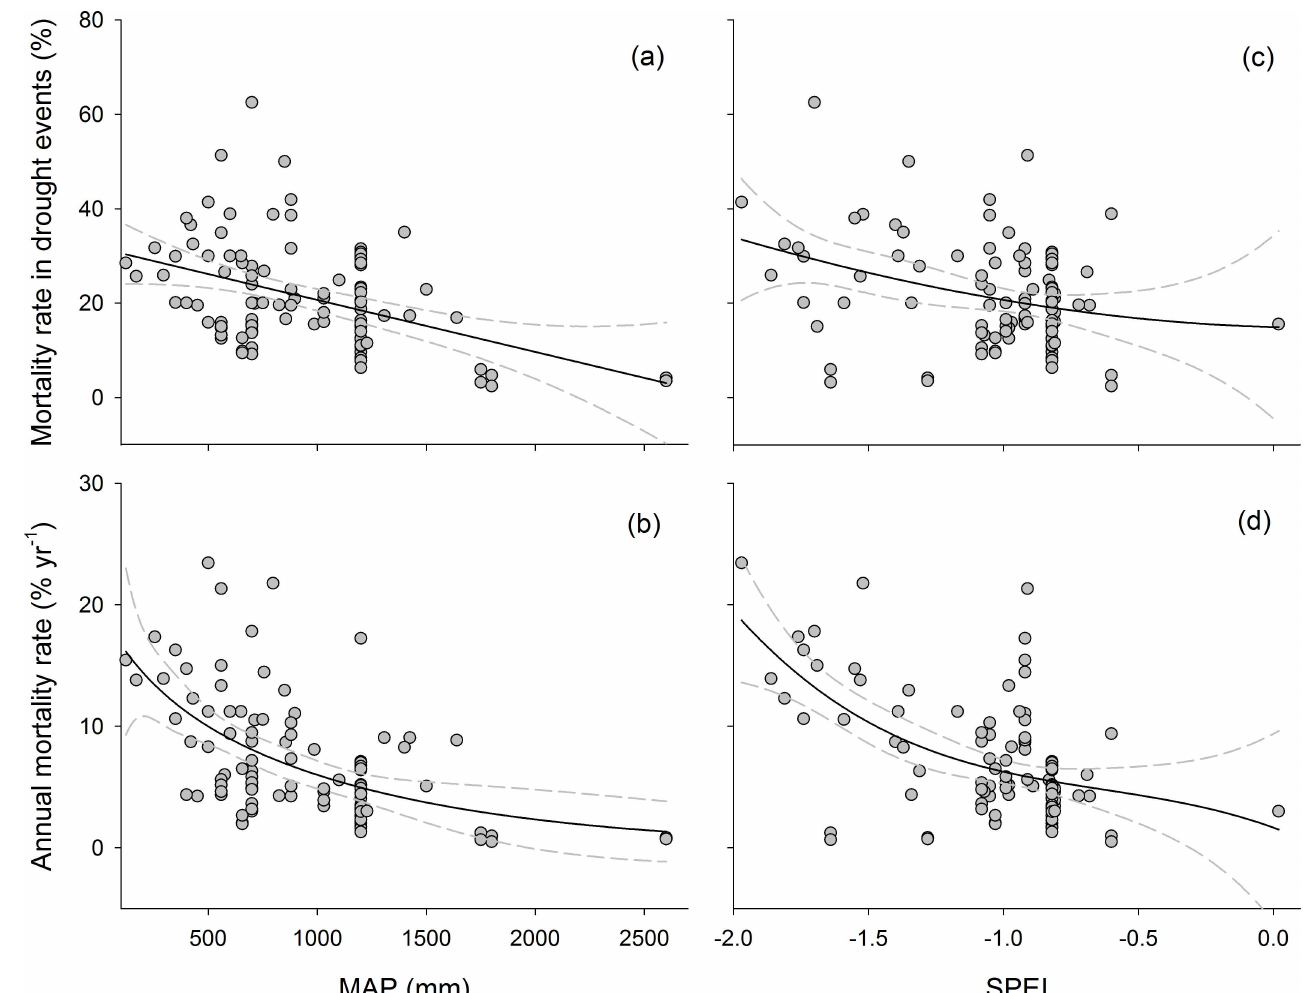
Fig 5. Sensitivity of mortality to drought for gymnosperms. (a) and (b) showedrelationships betweentree mortality metrics and MAP. (c) and (d) showedrelationshipsbetweentree mortality metrics and SPEI. Dark-grey dots indicate droughts. Dark-grey dots indicate droughts. The best-fit models for each drought index and mortality-rate metric are shown, with the 95% bootstrapped confidenceintervals. MAP, mean annualprecipitation; SPEI,